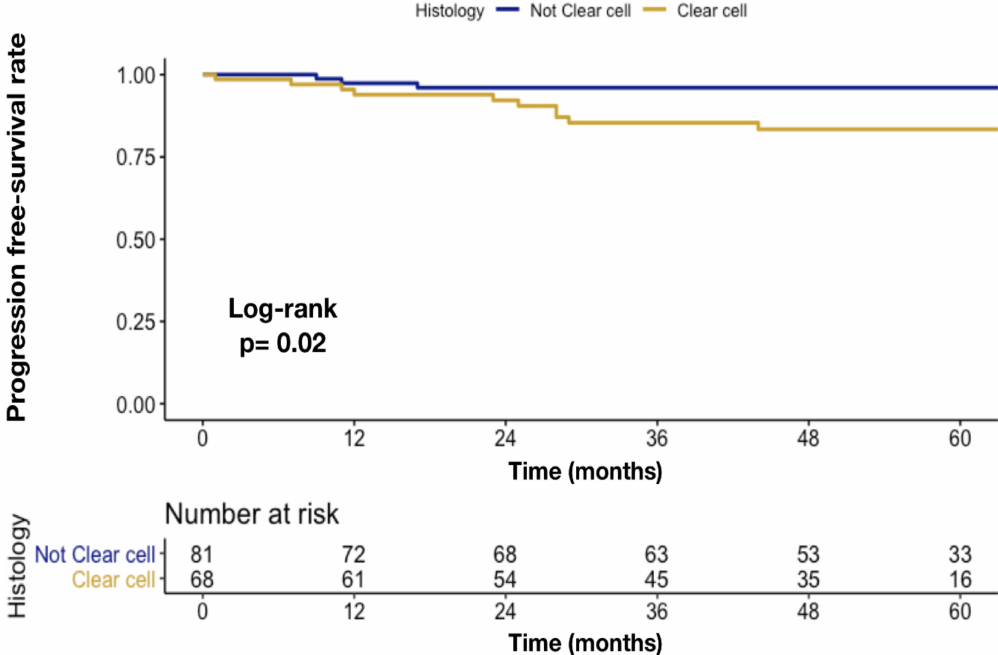
Figure 1. Kaplan-Meier plots depicting disease progression rate over time, according to histovariant clear cell RCC vs. not clear